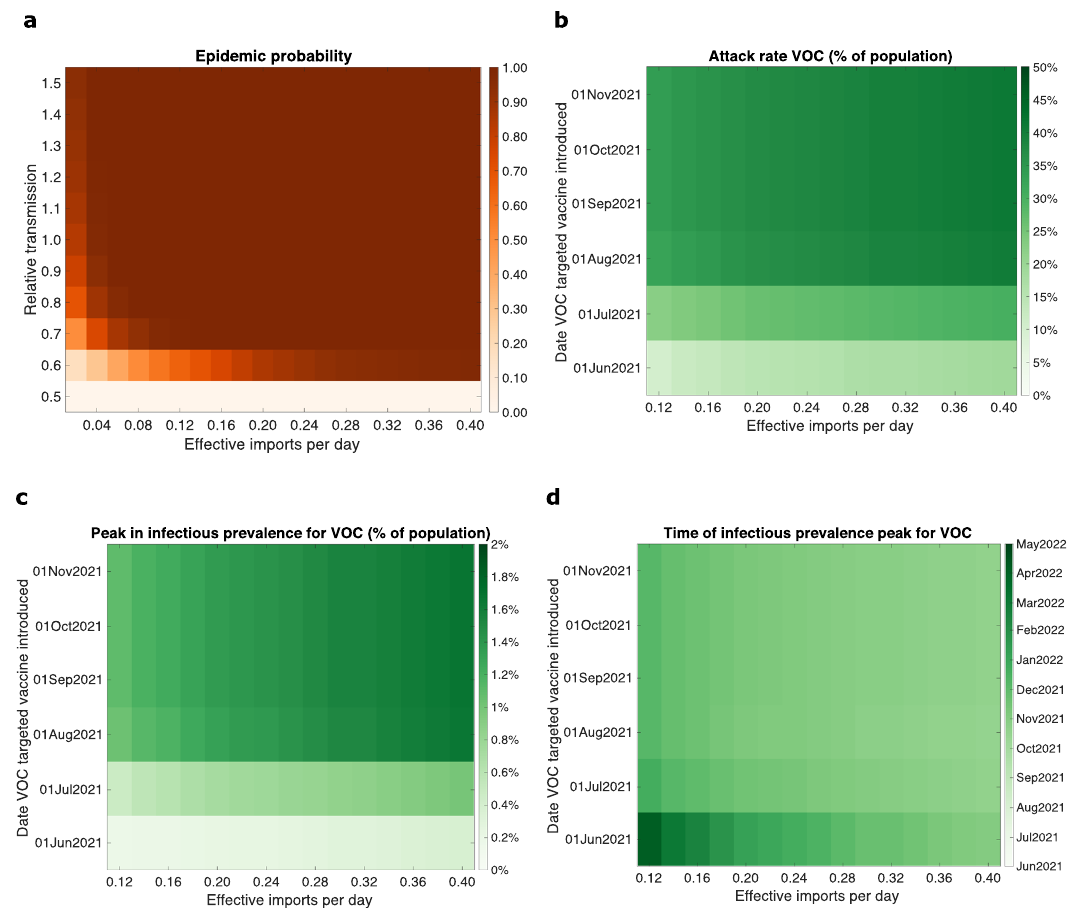
Fig. 3 Outbreak potential and sensitivity of epidemic trajectories to the introduction time of a variant of concern (VOC) targeted vaccine for VOC E. a The probability of an epidemic for varying relative transmissibilities (compared with resident variants) versus a given count of VOC-effective imports per day (corresponding to the second generation cases that result from a single-index case). In panels b – d , we performed simulations using the parsimonious SARS-CoV-2 transmission model for differing effective VOC importation counts and introduction date of a VOC-targeted vaccine and evaluated the following epidemiological summary statistics for the resultant VOC outbreak; b fi nal size; c peak in infectious prevalence; d time of peak in infectious